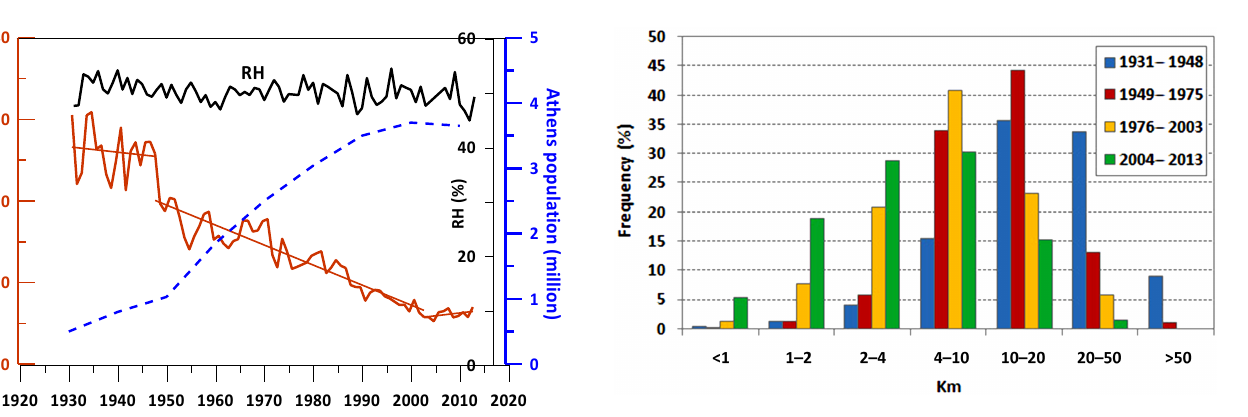
Figure 5. Relative frequency distribution of different visibility ranges (as defined in Table 2) in Athens for the four